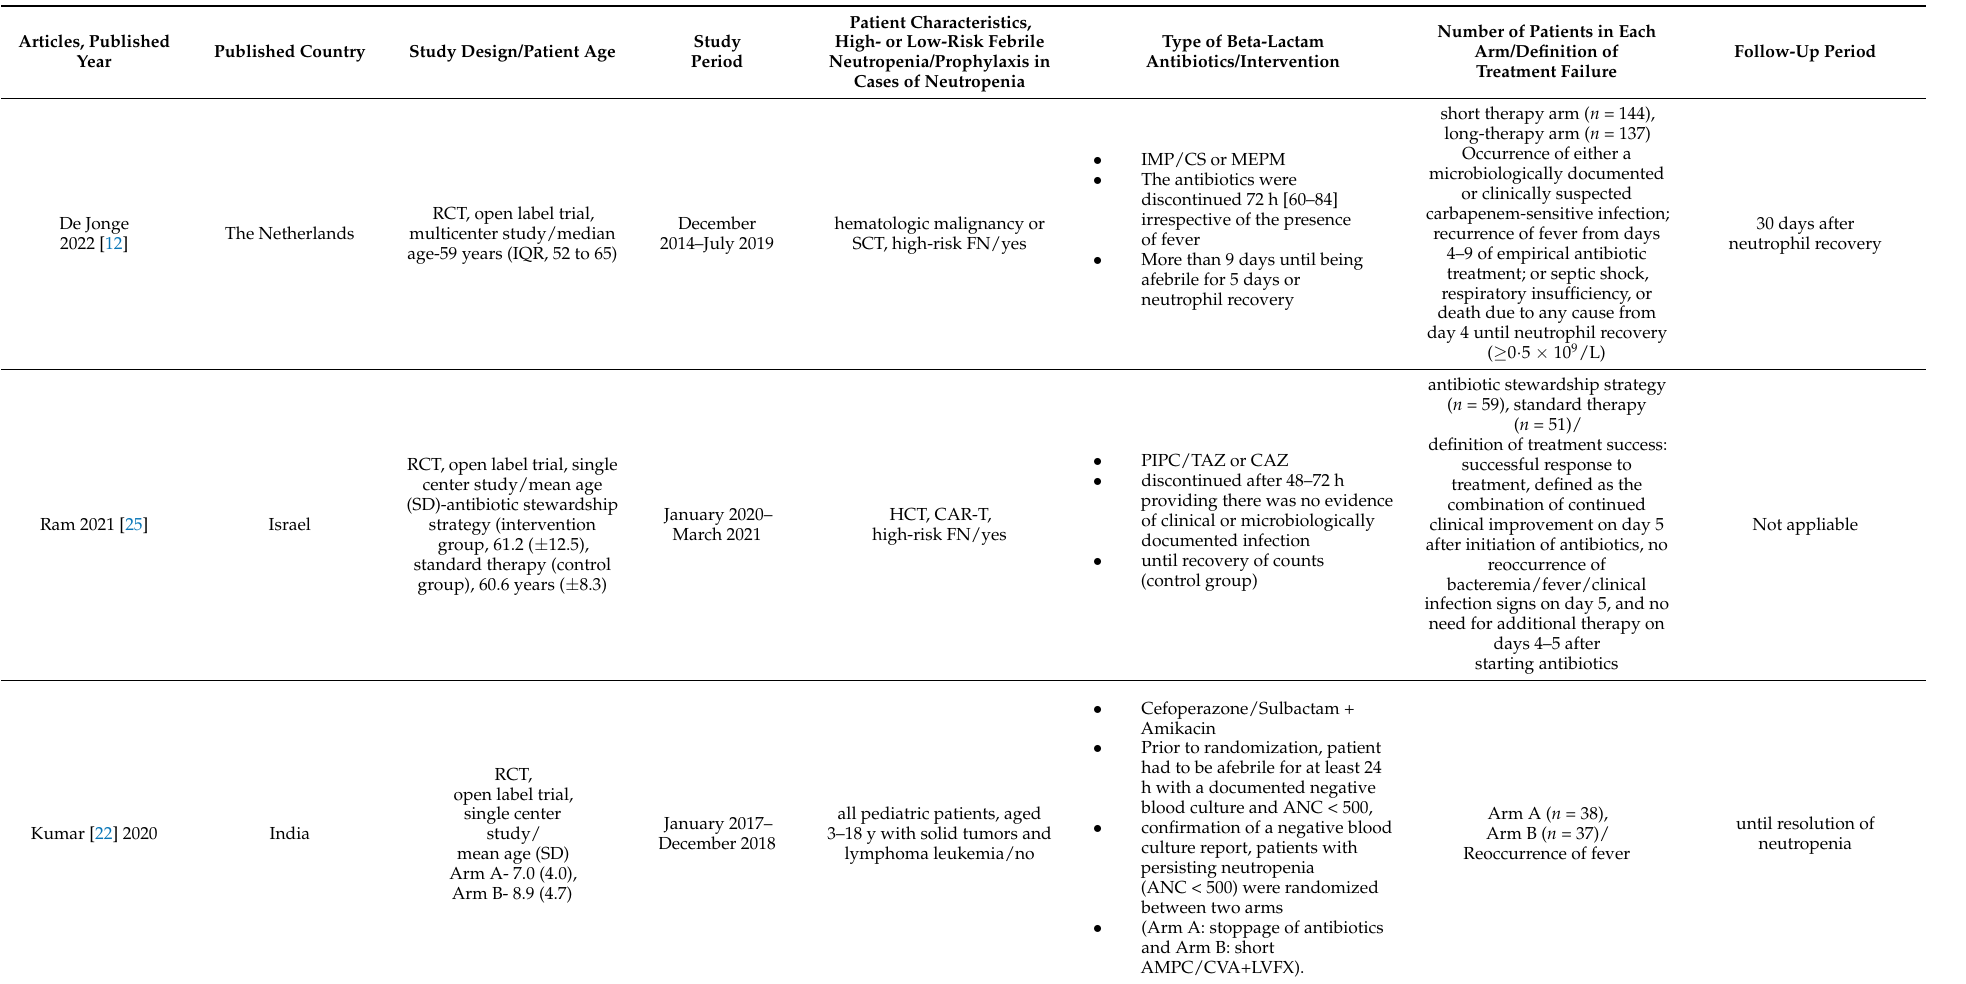
Table 1. Clinical characteristics of the included randomized controlled trials in our systematic